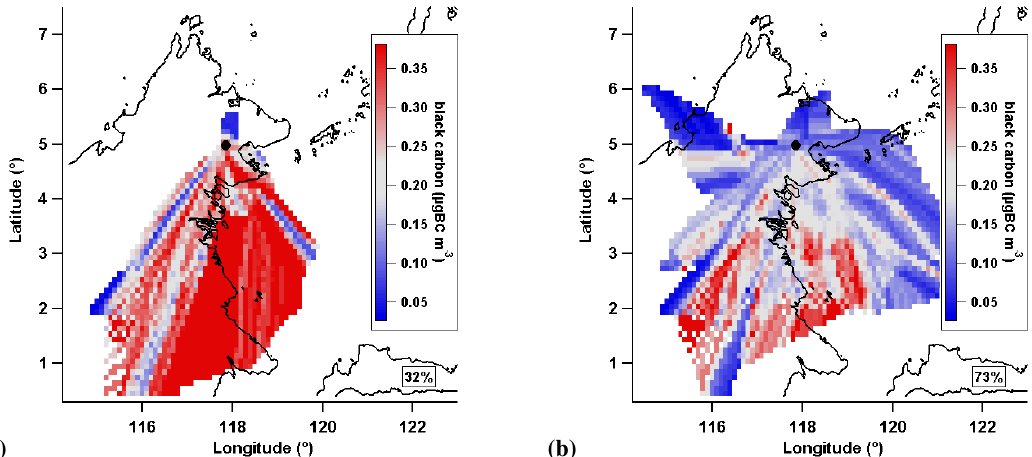
Fig. 18. Mean value maps of aerosol absorbance (expressed as black carbon equivalent loading) during (a) POI 1 and (b) POI 2. The colour scale is centred round the median value of the BC mean value map for the whole campaign.